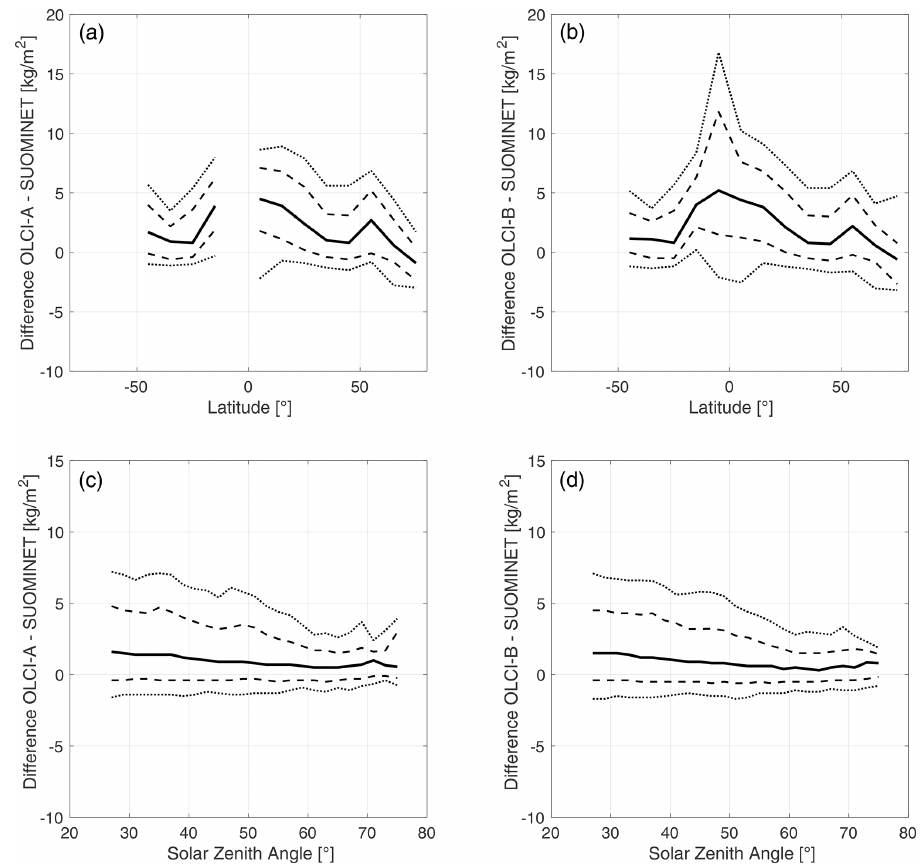
Figure 4. Difference OLCI-A (a, c) and OLCI-B (b, d) of observations against SuomiNet as a function of latitude (a, b) and solar zenith angle (c, d) . The solid line shows the median of each 2 ◦ wide bin, while the dashed lines show the 16th and 84th percentiles and the dotted lines the 5th and 95th percentiles. Bins with fewer than 20 matchups were omitted from the